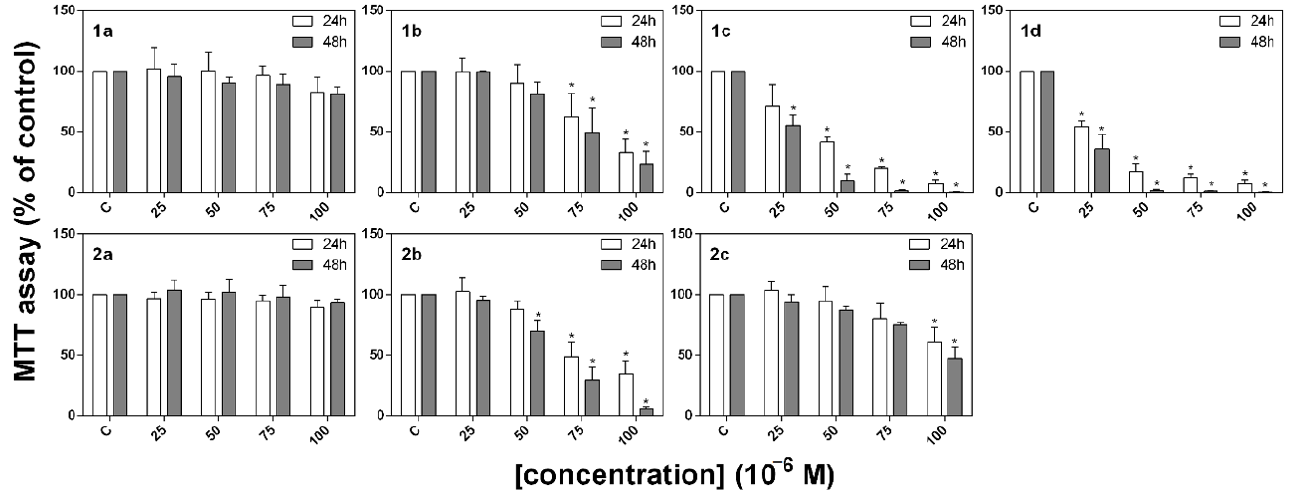
Figure 4. Effect of tacrine-coumarin hybrid compounds 1a – 2c on metabolic activity evaluated by MTT assay in A549 cancer cell lines. MTT assays are expressed as percentages of the untreated control. The results are presented as the mean values ± SD of three independent experiments; statistical significance (*): p < 0.05 for each experimental group compared to the untreated control.